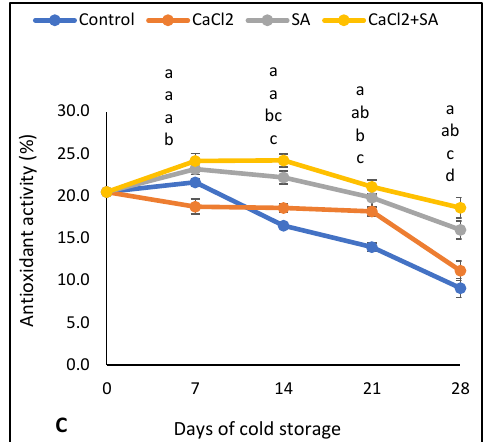
Figure 5. Effect of SA and CaCl 2 and their combination on ( A ) sulforaphane, ( B ) peroxidase activity, and ( C ) antioxidant activity of broccoli florets stored at 5 °C for 28 days. Values are means ± SE from three replicates ( n = 3). Same letter means no significant differences between the values ( p < 0.05) according to Duncan test.